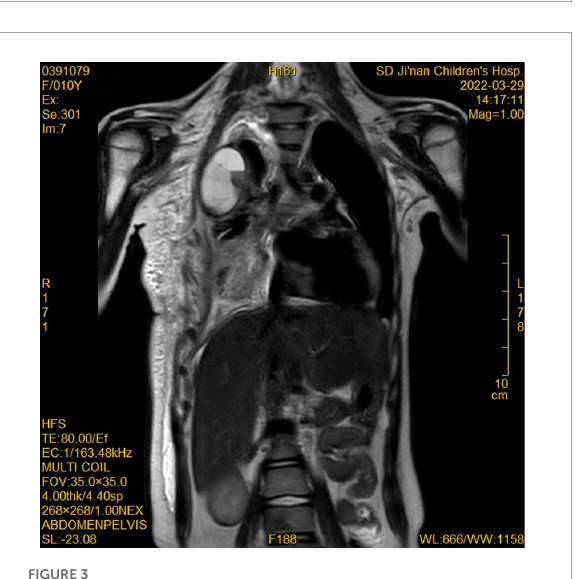
FIGURE2 Computed tomography (CT) imaging showed enhancement of chest wall lesions, atelectasis of the right lung, right encapsulated pleural effusion, and pleural thickening.